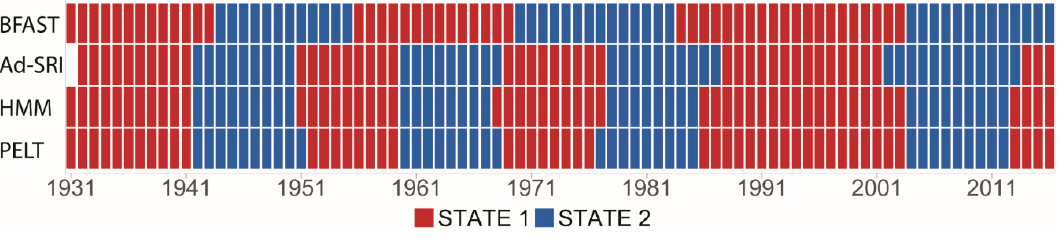
Figure 5. Comparison of the state classification methodologies for low-frequency variability. The first line is the identification using the breaks for additive seasonal and trend (BFAST) method, then the Standardized Runoff Index (SRI), followed by the Pruned Exact Linear Time (PELT) algorithm, and two-state hidden Markov model (HMM) classification.